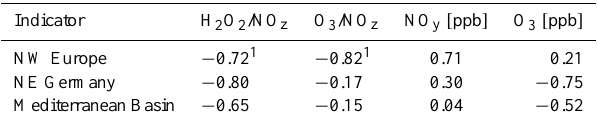
Table 4. Temporal correlation ( R ) between chemical regimes and indicators at 15:00UT during summer (May–August)